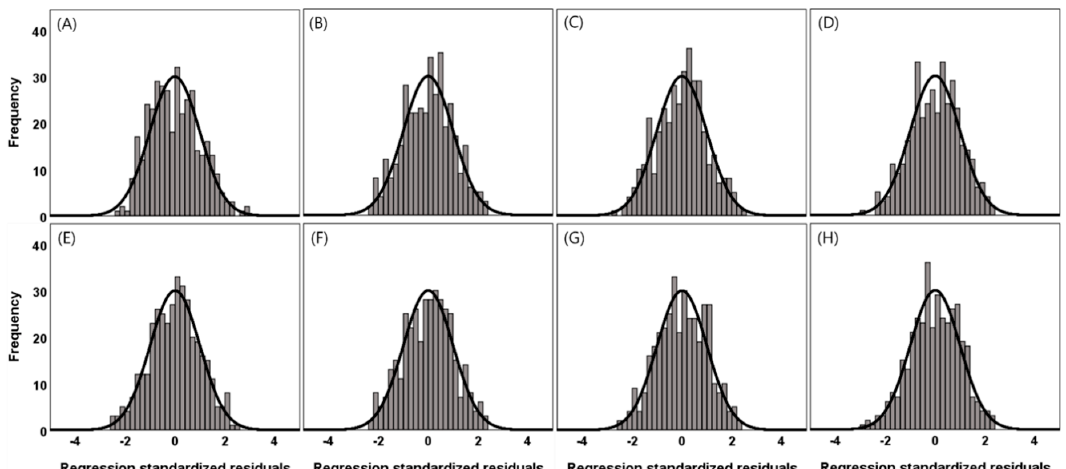
Figure 5. The distribution of the regression standardized residuals for each prediction Model ( A – H ): Model A = axle torque as a linear function of engine torque and engine speed; Model B = axle torque as a linear function of tillage depth; Model C = axle torque as a linear function of slip ratio and travel speed; Model D = axle torque as a linear function of engine torque, engine speed and tillage depth; Model E = axle torque as a linear function of engine torque, engine speed and travel speed; Model F = axle torque as a linear function of tillage depth and travel speed; Model G = axle torque as a linear function of engine speed, tillage depth and travel speed; and Model H = axle torque as a linear function of engine torque, tillage depth and travel speed.